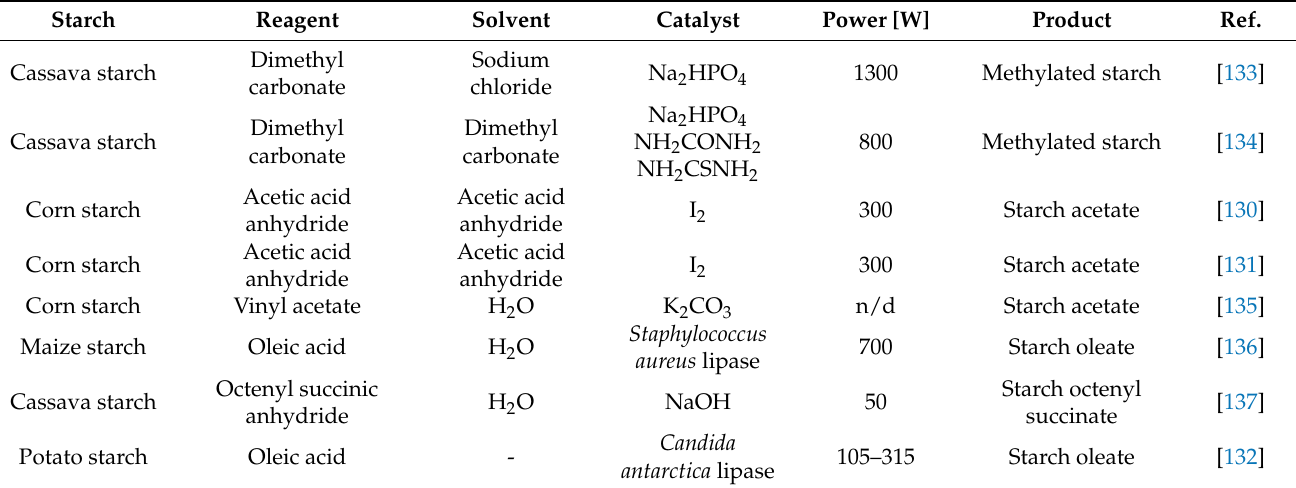
Table 2. Modification of starch under microwave